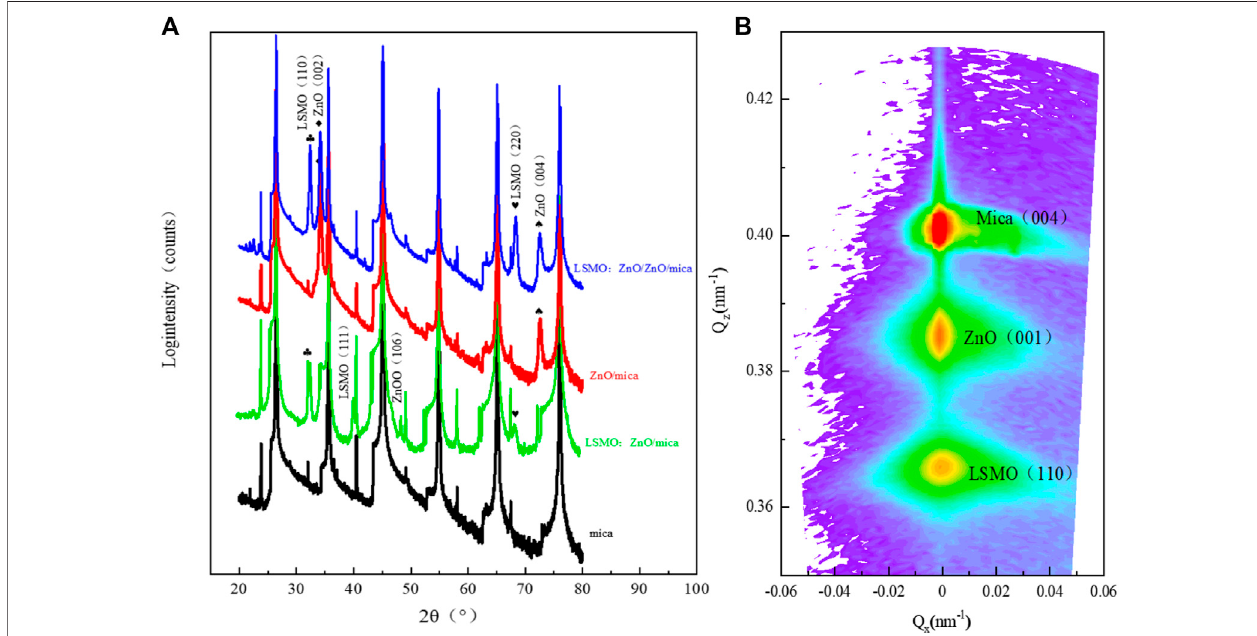
FIGURE1|(A) X-raydiffraction(XRD) θ -2 θ patternofthemica,LSMO:ZnO/mica,ZnO/mica,andLSMO:ZnO/ZnO/micasamples. (B) Reciprocalspacemap(RSM) of the LSMO:ZnO/ZnO/mica